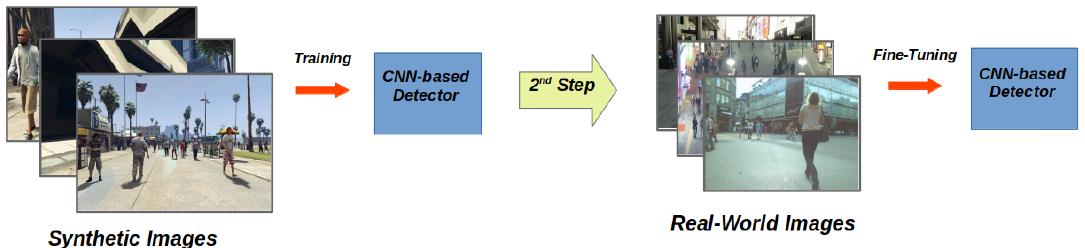
Figure 4. Overview of the first domain adaptation technique. In a first step, we train the detector using ViPeD, our synthetic collection of images. Then, in a second step, we fine-tune the network using real-world